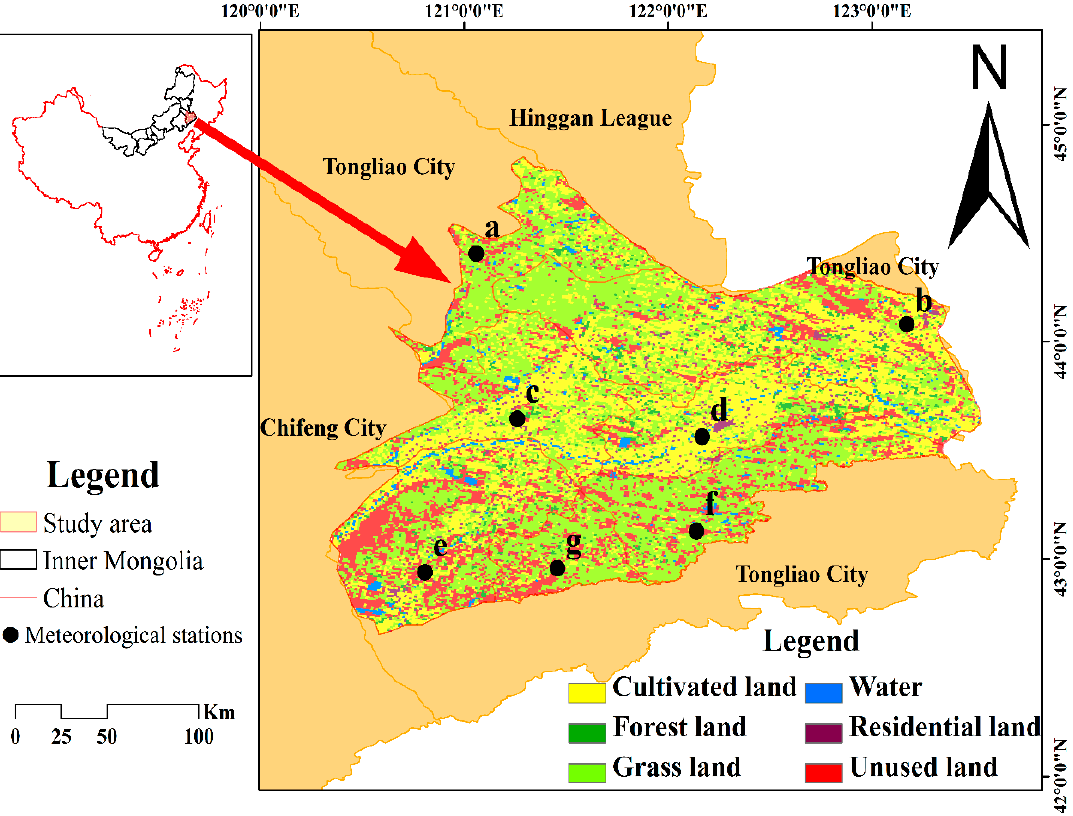
Figure 1. Location of the study area (Land-Use and Land-Cover Change data from 2015 are from Data Center for Resources and Environmental Sciences, Chinese Academy of Sciences (http://www.resdc.cn)).